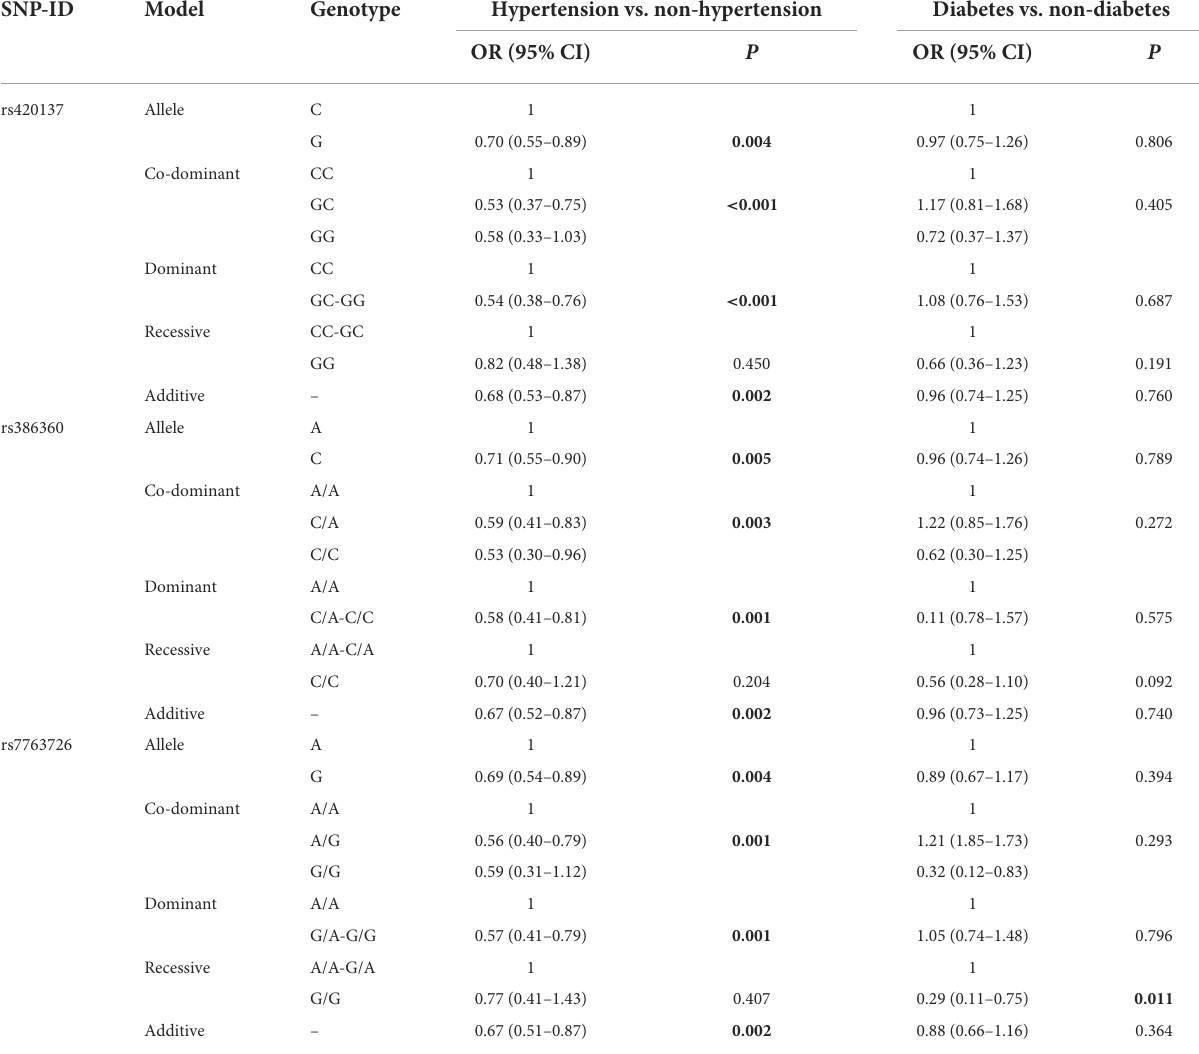
TABLE 6 FNDC1 SNPs associated with CHD risk stratified by hypertension vs. non-hypertension and diabetes vs. non-diabetes.